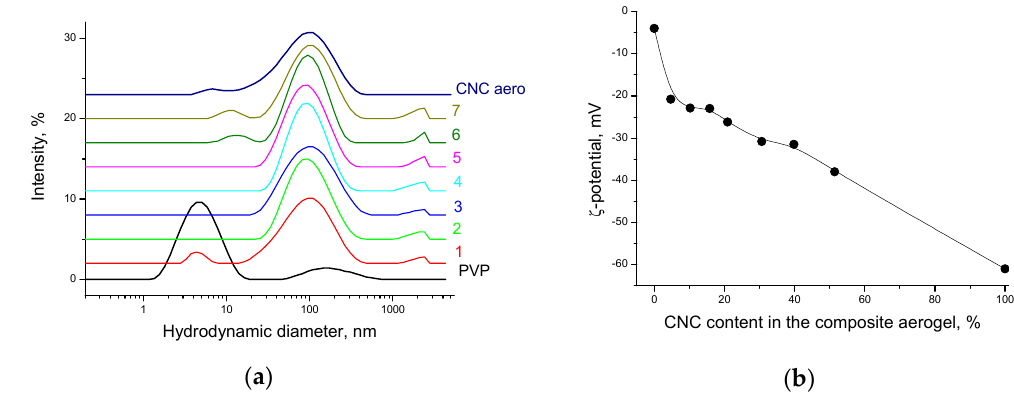
Figure 13. ( a ) Particle size distribution of the PVP/CNC aerogels in water (for comparison, the curves for the neat PVP and CNC are shown): 1 - PVP/CNC-4.6 aero; 2 - PVP/CNC-10.9 aero; 3 - PVP/CNC-16.3 aero; 4 - PVP/CNC-19.6 aero; 5 - PVP/CNC-28.9 aero; 6 - PVP/CNC-37.9 aero; 7 - PVP/CNC-54.5 aero. ( b ) Surface charge of PVP coated CNC particles after redispersion of the PVP/CNC aerogels in water.